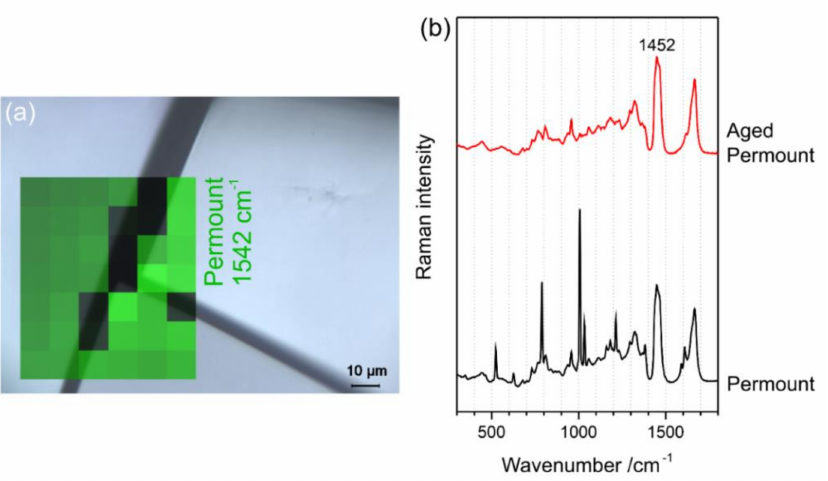
Figure 15. ( a ) Reflected light micrograph of Permount TM after accelerated ageing at T = 80 ◦ C for 10 days overlaid with the Raman distribution map of Permount TM , and ( b ) Raman spectra of this aged and of pristine Permount TM